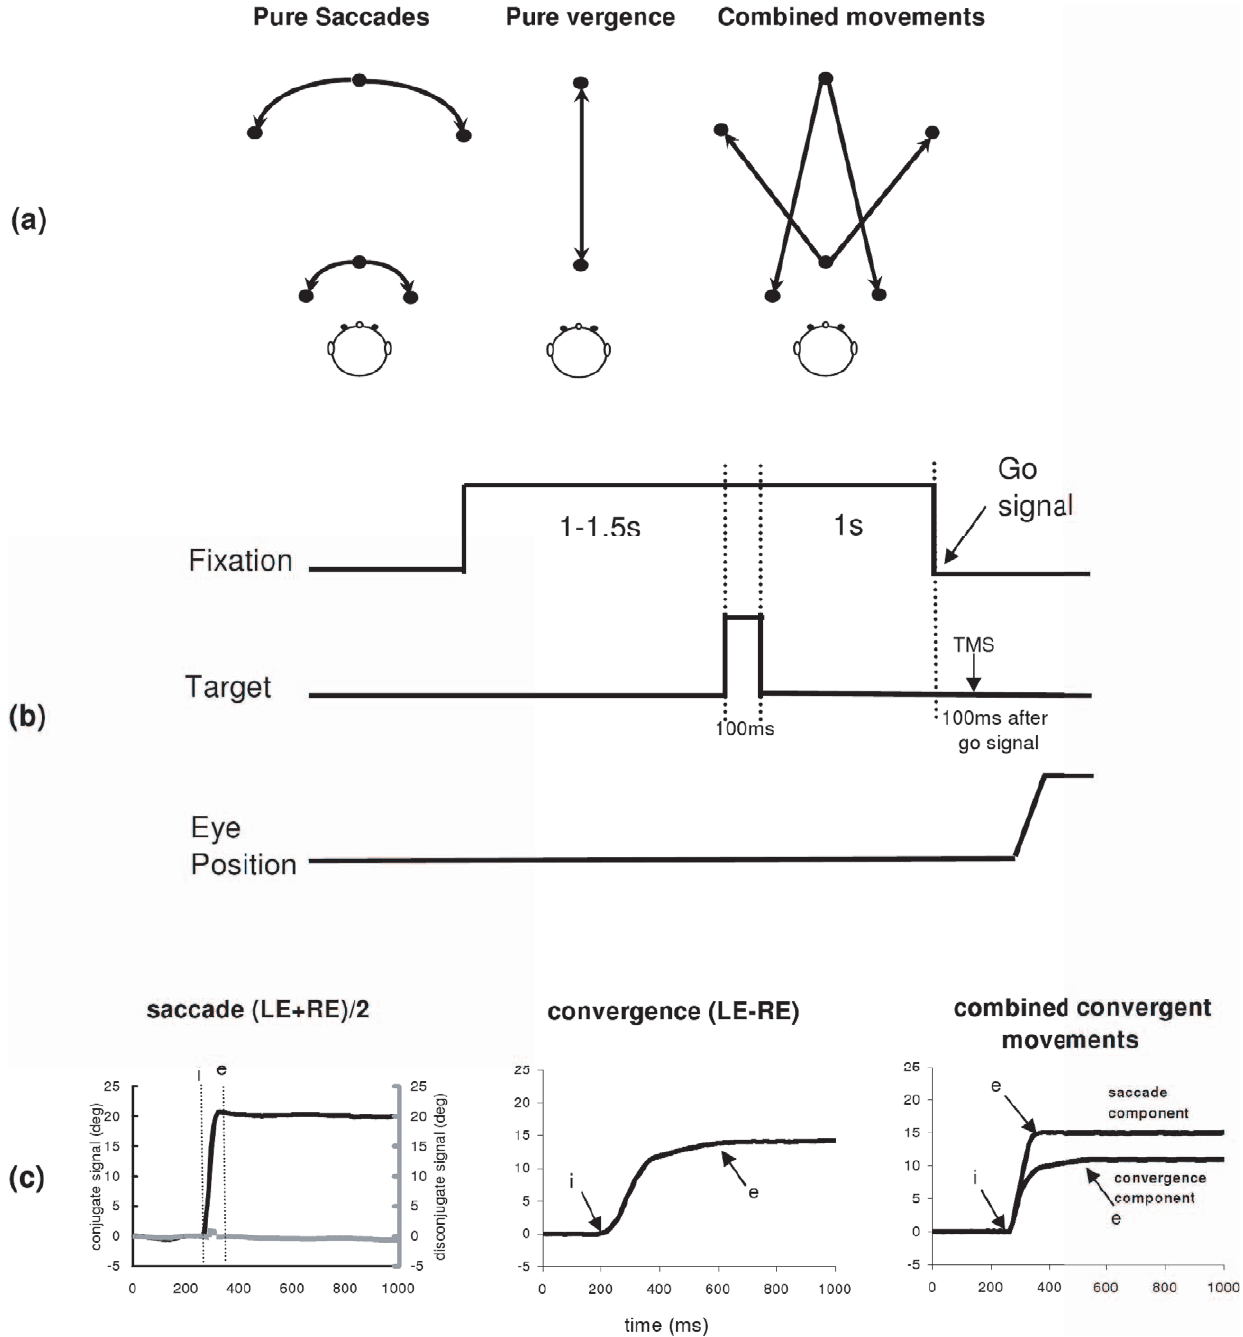
Figure 7. Experimental paradigms. (a) Different types of eye movements elicited; saccades, convergence and divergence along the median plane, and combined convergent or divergent movements. (b) Events during a trial of the paradigm for memory-guided eye movements. (c) Typical recordings of saccades (conjugate signal in black and disconjugate signal in grey), convergence and combined convergent movements; the conjugate signal (saccade or saccade component) is obtained by averaging the position signal of the two eyes (LE + RE)/2; the disconjugate signal (convergence, convergence component) is the difference between the two signals LE-RE. The arrows at ‘ i ’ and at ‘ e ’ indicate the onset and the end of movements, respectively.